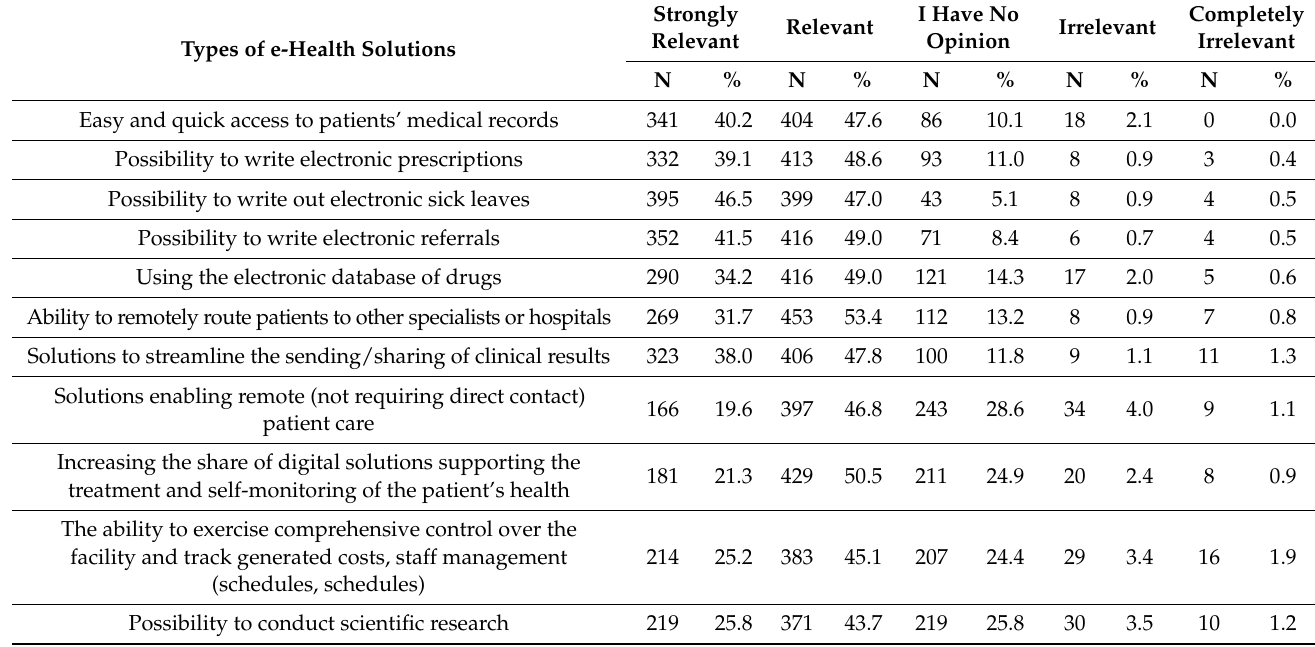
Table 5. Nurses’ opinions on the use of e-health solutions in the health care